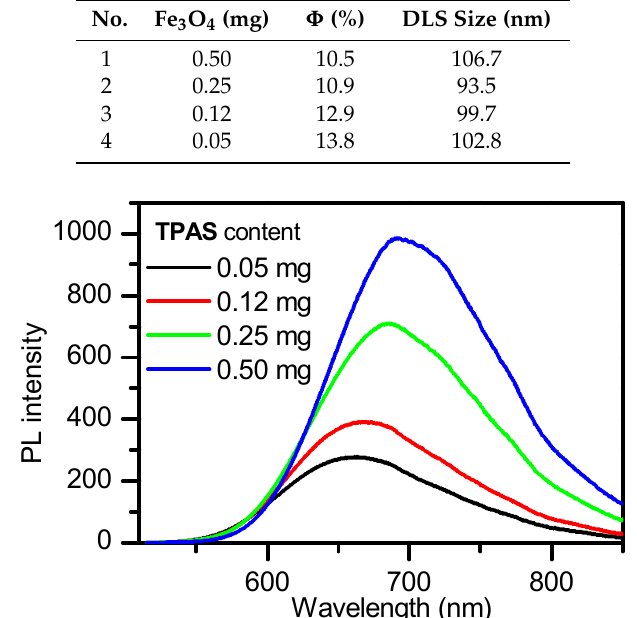
Figure 3. PL spectra of AIE–Fe nanodots containing different amount of TPAS (conditions: Fe 3 O 4 0.5 mg, Pluronic F127 10 mg, H 2 O 10 mL).